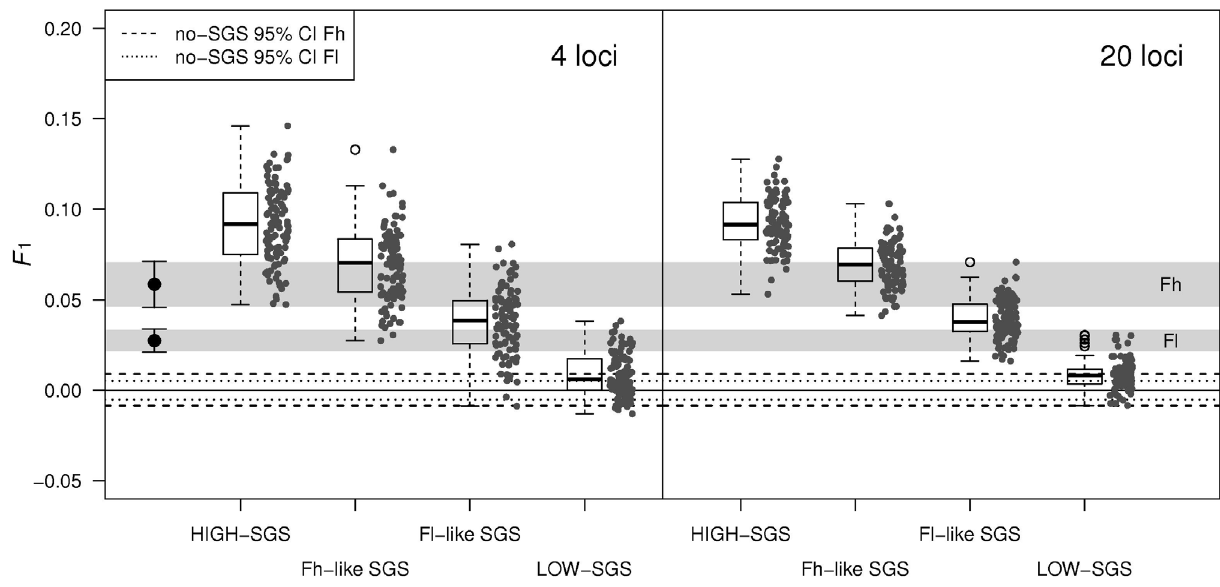
Figure 2. Assessment of the power of the marker set to detect SGS by spatially explicit simulations. For illustration of the results, the distribution of the kinship coefficient F 1 between neighbours at generation 64 was used as the focal statistic (grey dots and boxplots) and compared to i ) the no-structure 95% confidence intervals of F 1 from the Fh and Fl populations (dotted lines, see legend in the left panel) obtained by random shuffling of individual geographic locations, and ii ) real F 1 values from Fh and Fl (black dots in the left panel) and their confidence intervals (grey areas). Results from simulations with 4 and 20 loci (right and left panels, respectively) are reported. Parameter settings for the 4 simulated scenarios were s g= 12 m and D=20 trees/ha (HIGH-SGS), s g= 12 m and D=35 trees/ha (Fl-like SGS), s g= 29 m and D=50 trees/ha (Fh-like SGS), s g= 72 m and D=145 trees/ha (LOW-SGS).